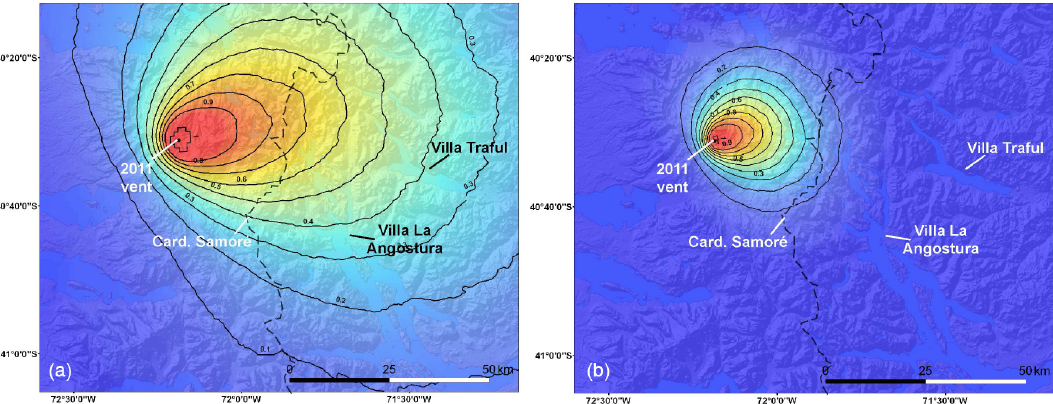
Figure B1. Hazard maps showing the spatial distribution of the probability of reaching a tephra accumulation of (a) 1 and (b) 100kgm − 2 (see also Fig. 8 of main text).